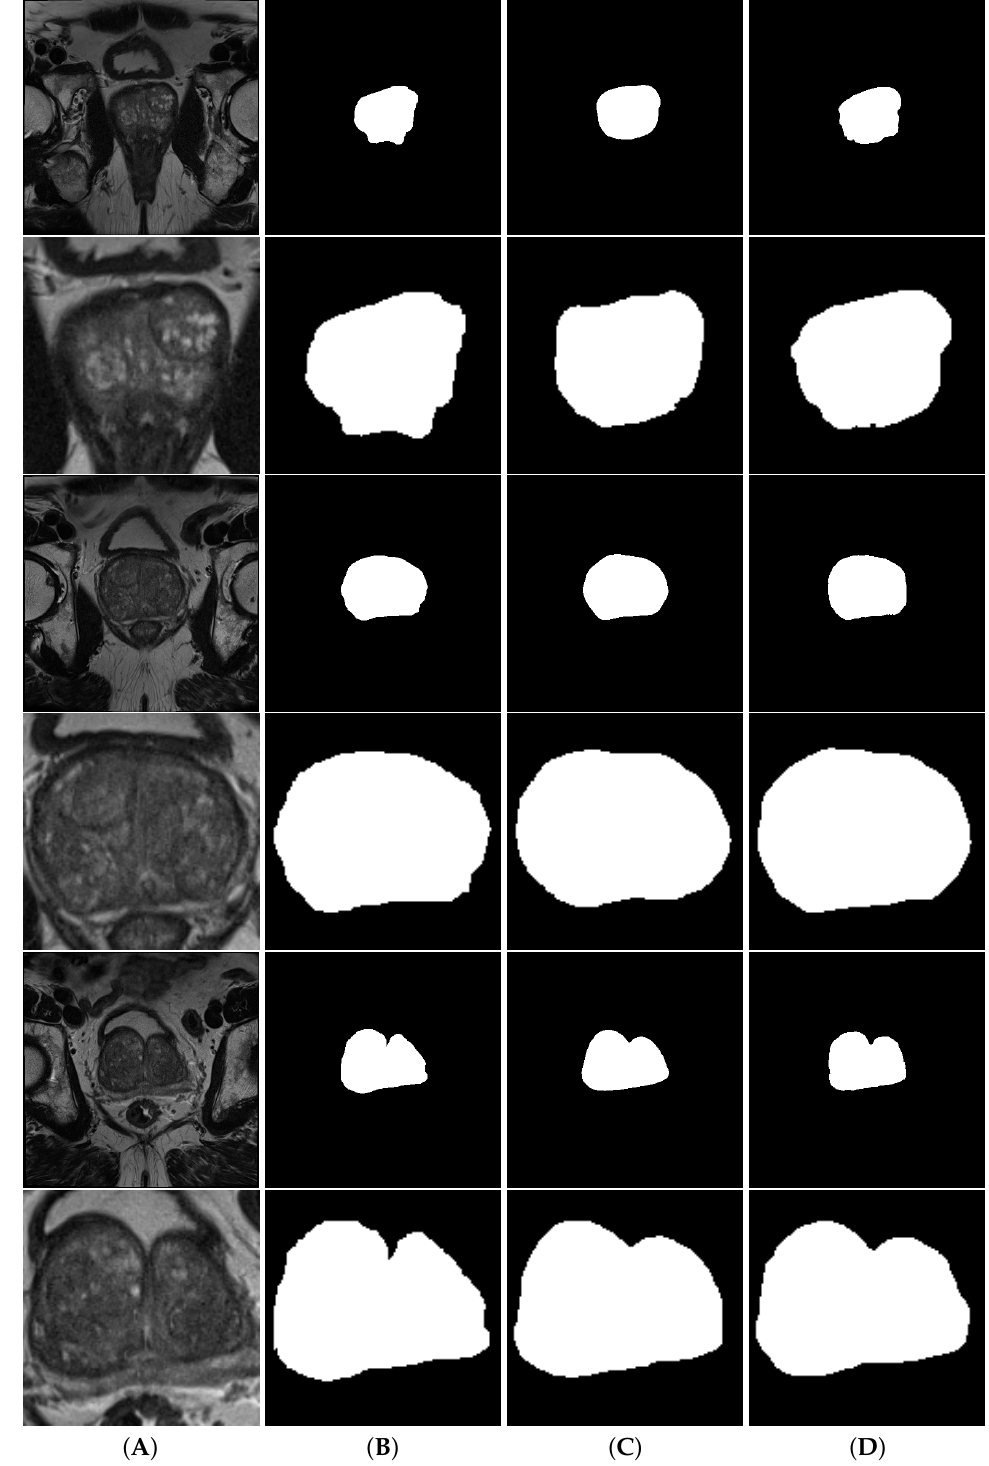
Figure 7. Segmentations of the transition zone. Column ( A ) contains the volumes, column ( B ) contains the ground truth, column ( C ) contains the nnunet segmentations and column ( D ) contains the aunet segmentations. Rows are interleaved, showing a full volume and a model cropped by the object detection model,